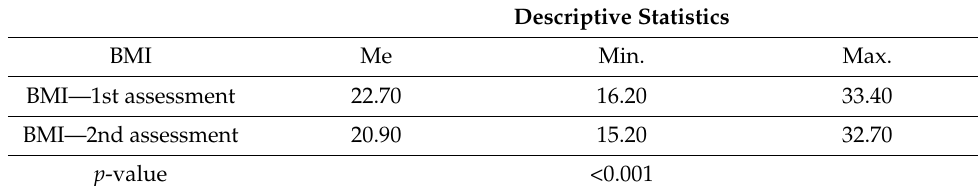
Table 5. BMI assessment.